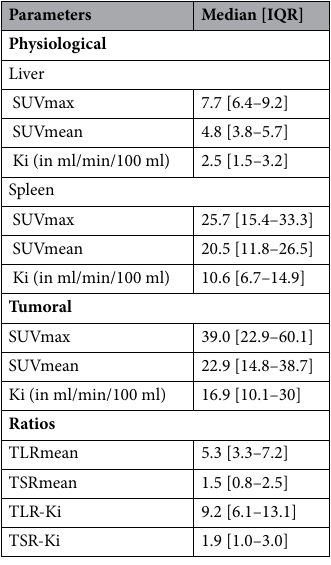
Table 2. Median values of static and dynamic